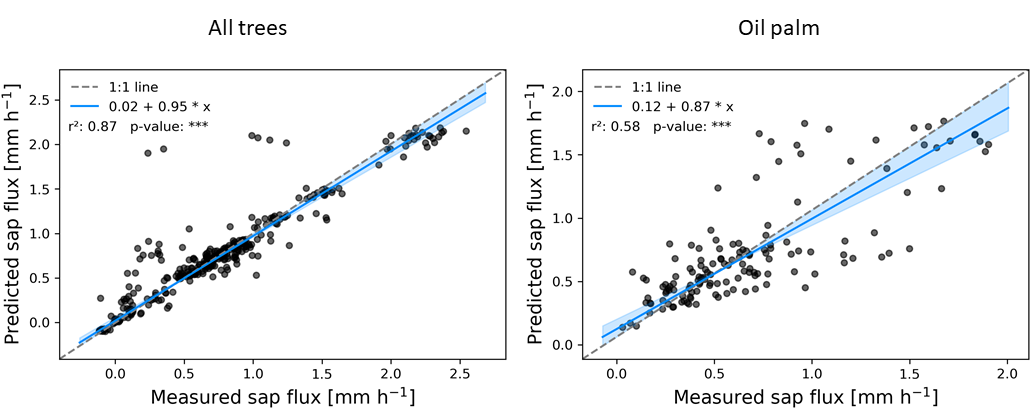
Figure 7. Measured and predicted sap flux for all tree and palm canopies from the RF bagging algorithm. The regression line of the Passing-Bablok regression is displayed in blue. The coefficient of determination is indicated by r² and the *** indicate a p-value well below 0.001.